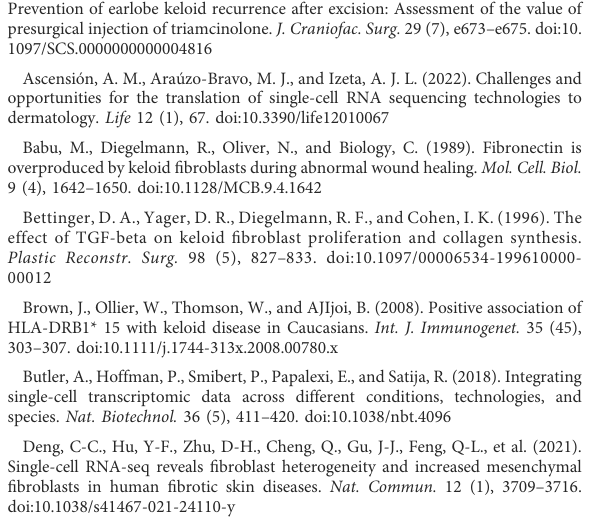
SUPPLEMENTARY FIGURE S1 (A) Volcano map of differentially expressed KECs and NECs in the GSE121618 dataset. (B) Heat map of differentially expressed genes. SUPPLEMENTARY FIGURE (S2) A Analysis and annotation of subpopulations of endothelial cells and fi broblasts in the single-cell sequencing dataset GSE163973. (B) Expression of RELA, NFKB1, NFKB2, RELB, and REL genes in different cells. The expression of RELA, NFKB1, NFKB2, RELAB, and REL was found tobehigherinimmunecells,Endo0,thaninothercells. (C) Transcription factor activity of RELA, NFKB1, NFKB2, RELB, and REL in different cell types. The graph shows signi fi cant activation of RELA, NFKB1, RELB, and RELinimmunecells,Endo2,Endo0,andNFKB2inLymphaticendothelial cells. (D) Distribution of the three fi broblast subpopulations in the six samples. (E) Fibroblast_1 is the typical mesenchymal type of fi broblast and is the main fi broblast type responsible for keloid lesions. (F,K) CXCL signaling pathway and types of major interactions. (G,L) IL6 signaling pathway network and main interaction types. IL6+ CSF3+ Endo2 is the main player, acting on immune cells and Lymphocyte endothelial (H, M) TNF signaling pathway network and main interaction types. Immune cells act mainly through the TNF signaling pathway on other cell types. (I, N) CCL signaling pathway network and main types of interaction. Endothelial cells and muscle fi broblast are the main players (J,O) CSF signaling pathway network and main interaction types. SUPPLEMENTARY FIGURE S3 Endo3isanendothelialprogenitorcell. (A) CD34ismosthighlyexpressed in Endo3, and (B) KDR is more highly expressed in Endo3. These two genes are the main markers of endothelial progenitor